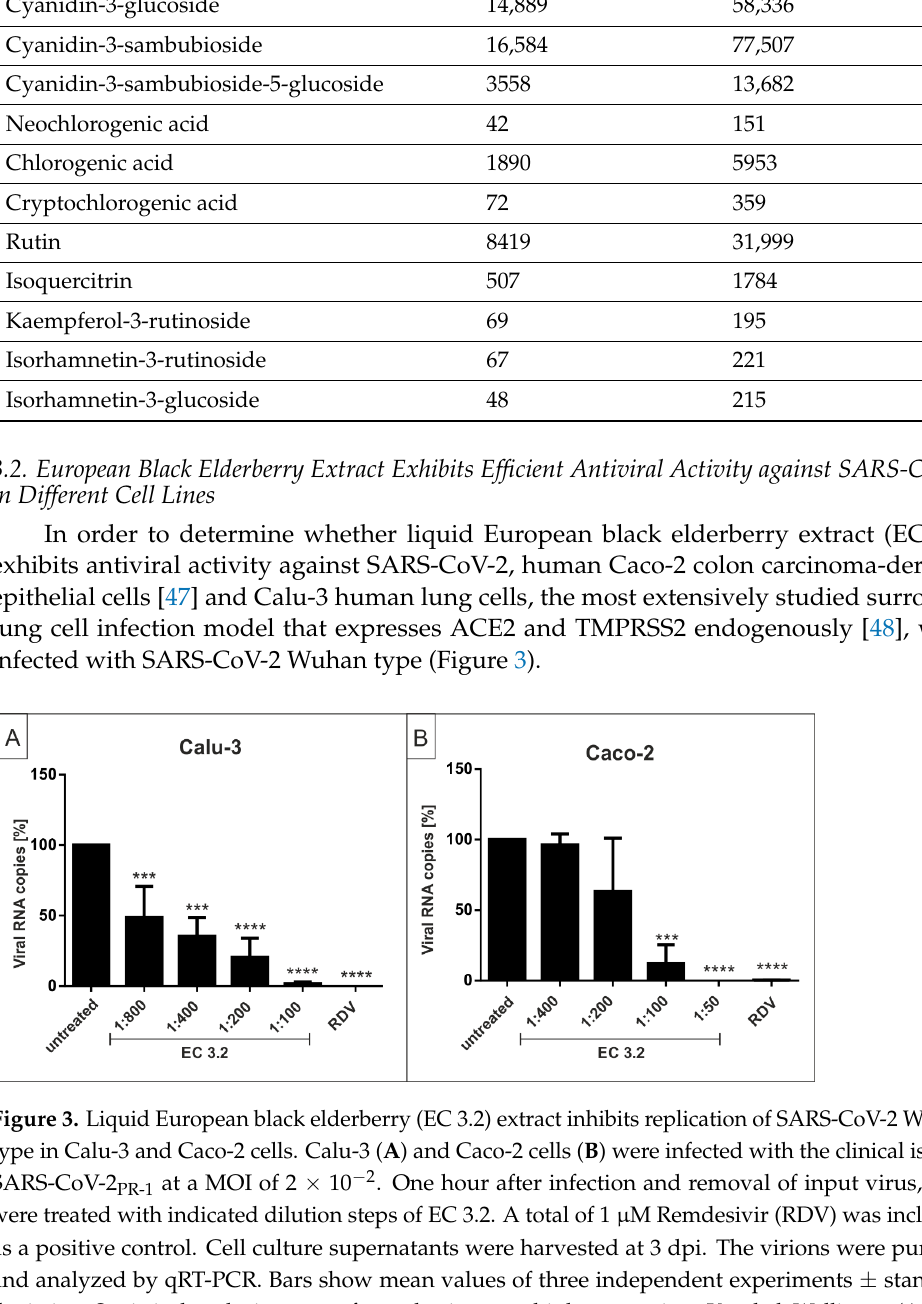
Figure 4. Influence of EC 3.2 on the cell viability of Calu-3 ( A ) and Caco-2 cells ( B ). Following treatment with different dilutions of EC 3.2 (indicated at the x-axis) for three days, the influence on cell viability was measured by water-soluble tetrazolium salt (WST)-1 assay. Bars represent means of 3 independent experiments ± SD. Staurosprine (StS, 1 μ M) was used as a positive control.